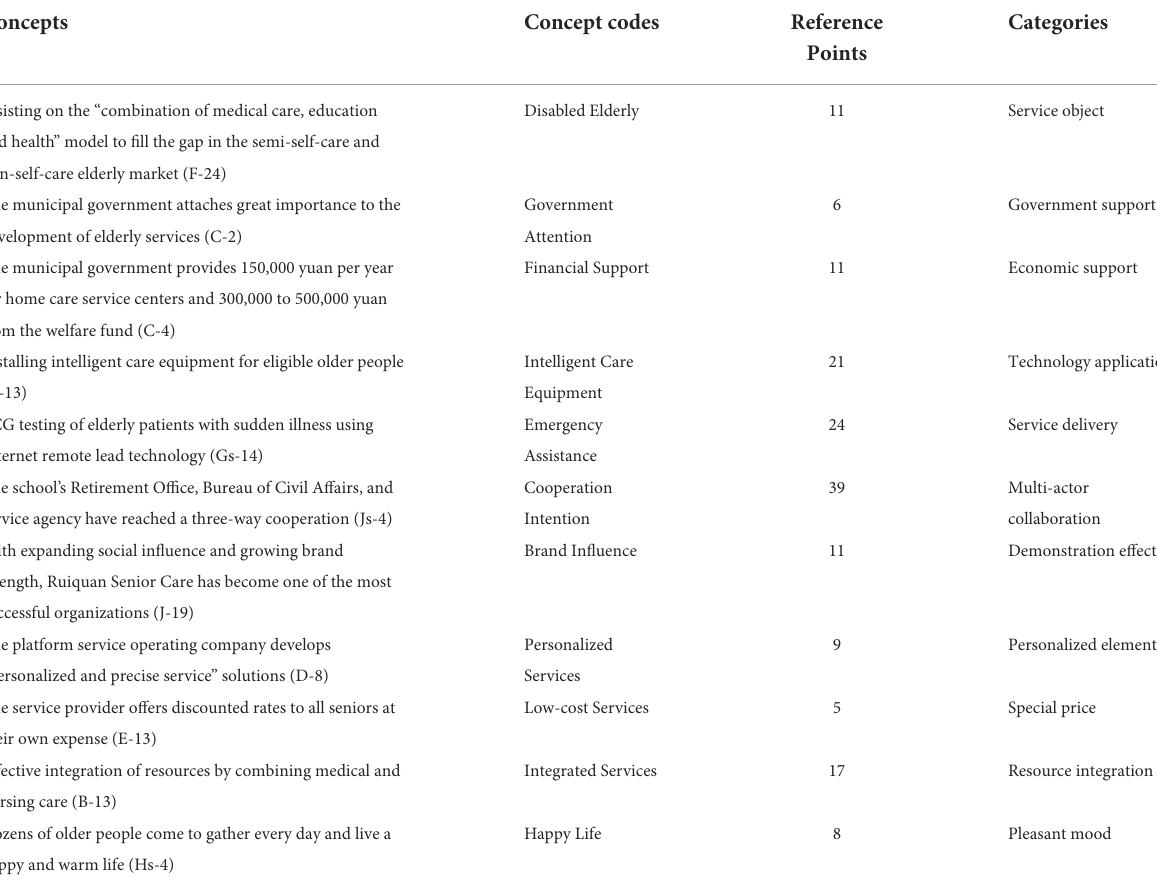
TABLE 2 Open coding